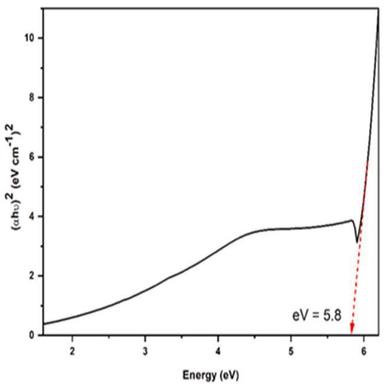
Tauc Plot of MTZ - ZnMoO4 nanocomposite which derived from UV-Vis absorption. Where band gap value (Eg) was 5.8 eV.